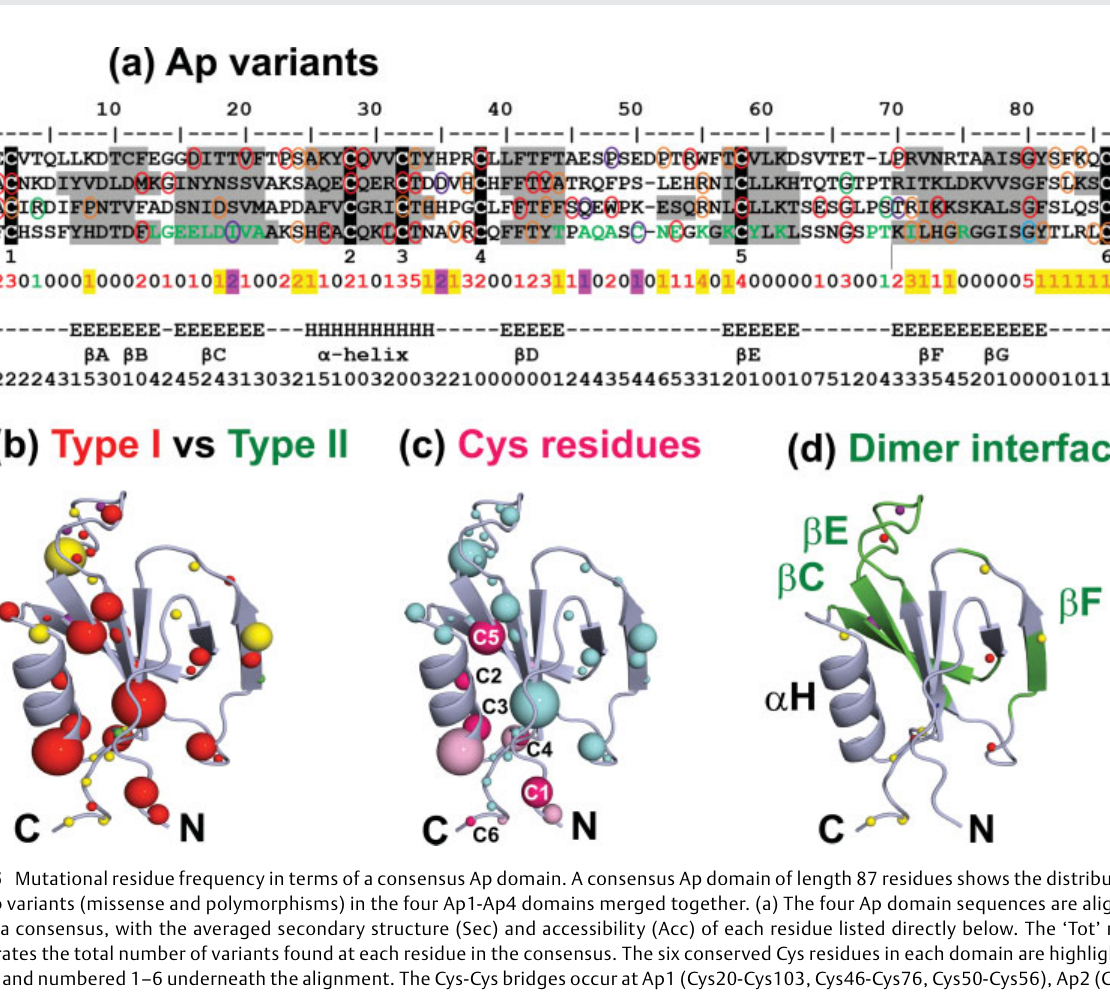
TH Open Vol. 5 No. 4/2021 © 2022. The